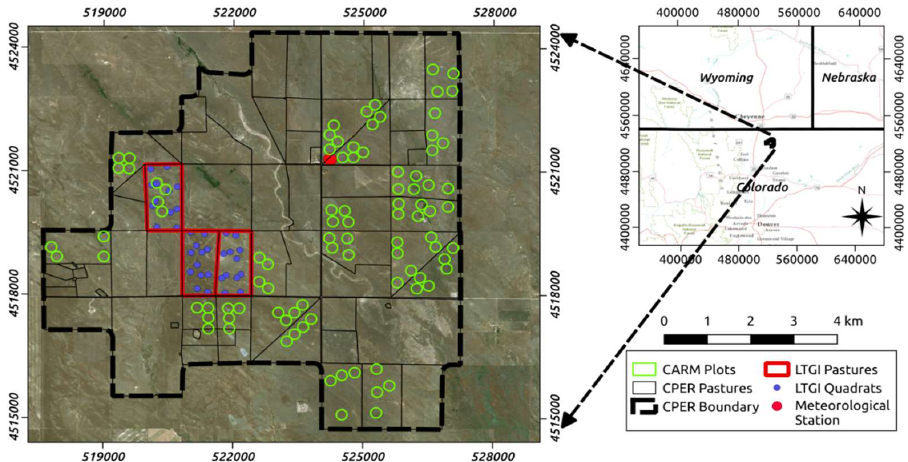
Figure 1. Overview map showing the study area, pasture boundaries, and vegetation sampling locations (coordinates in EPSG 32613). The dashed black outline delineates the USDA ARS Central Plains Experimental Range